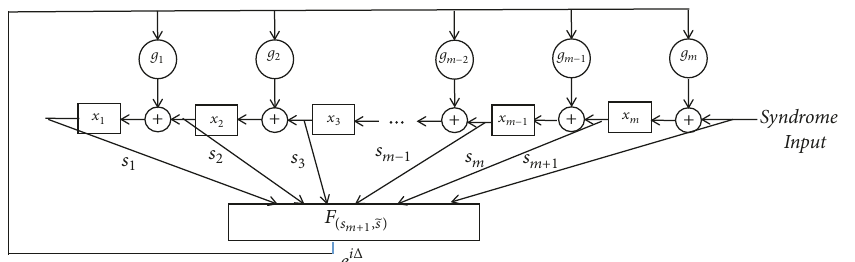
Figure 2: Decoder